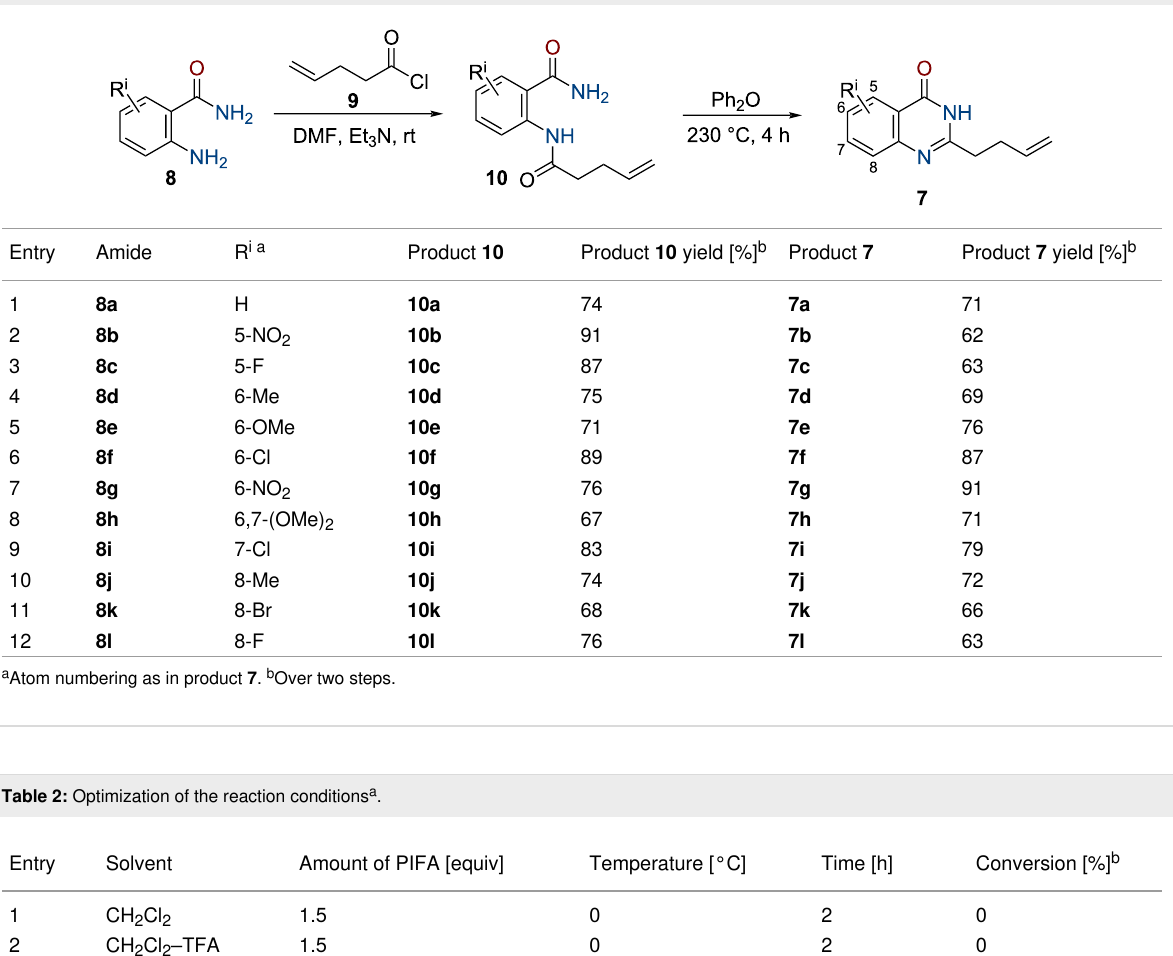
Table 1: Synthesis of 2-(buten-3-yl)quinazolin-4(3 H )-ones 7 .